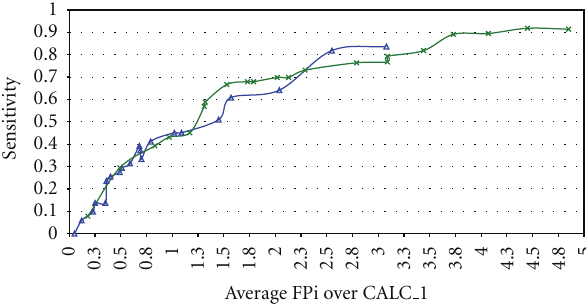
Figure 3: Free-response operating characteristic curves for systems with the feature extraction configurations ICA-D13C40 (blue trace) and ICA-D17C20+AGE (green